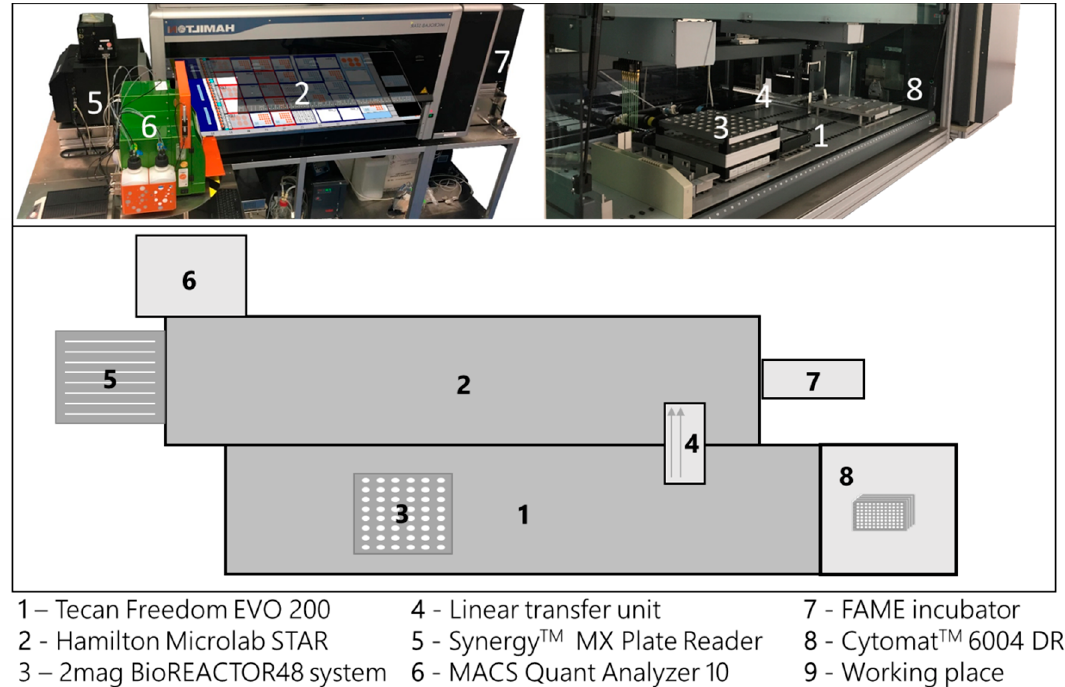
Figure 2. Schematic description of the high-throughput bioprocess development facility used in this study. Composition of the two liquid handling stations (LHS, 1 and 2) and a mini-bioreactor system (3). The liquid handling stations are connected by a linear transfer unit (4) for automatic sample exchange. The facility is surrounded by supporting laboratory equipment (5–8), all accessible by one of the liquid handling stations.